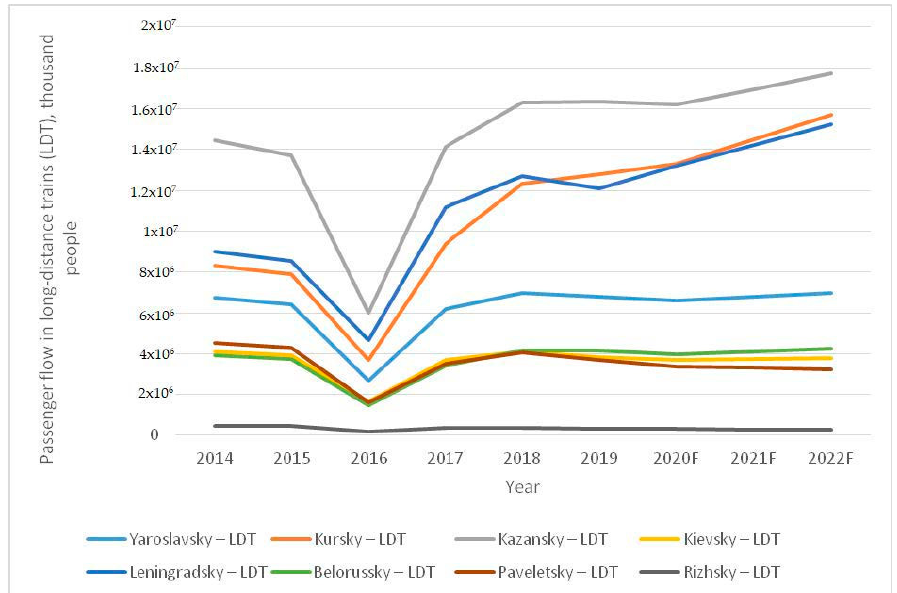
Figure 4. Passenger flow in commuting trains (CT) at Moscow rail stations and its forecast, people.